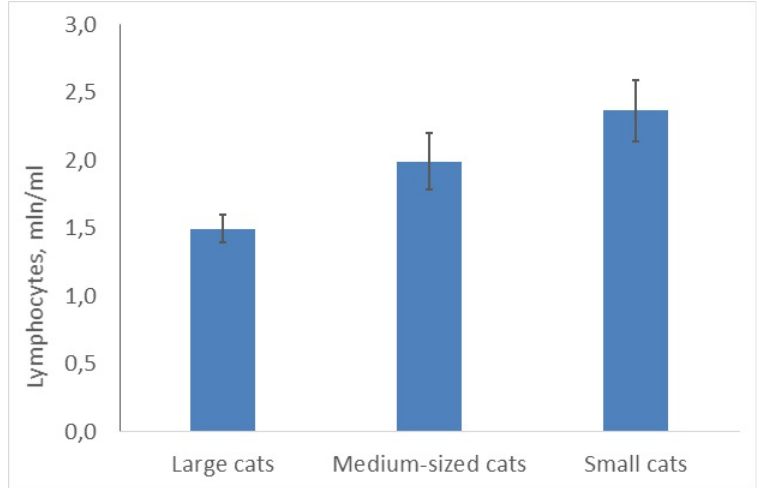
Figure 3. Average lymphocyte number is higher in smaller cats than in bigger ones.